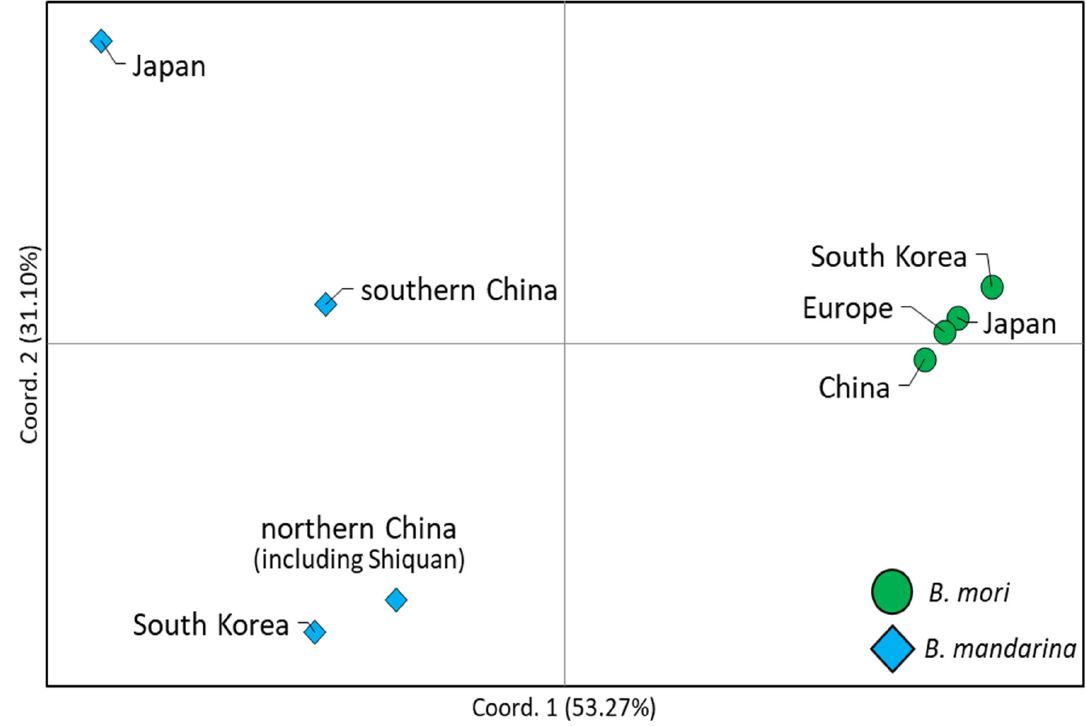
Figure 4. Principal coordinate analysis based on populations. The percentages of variation explained by the first and second components are indicated in the x and y axes, respectively.